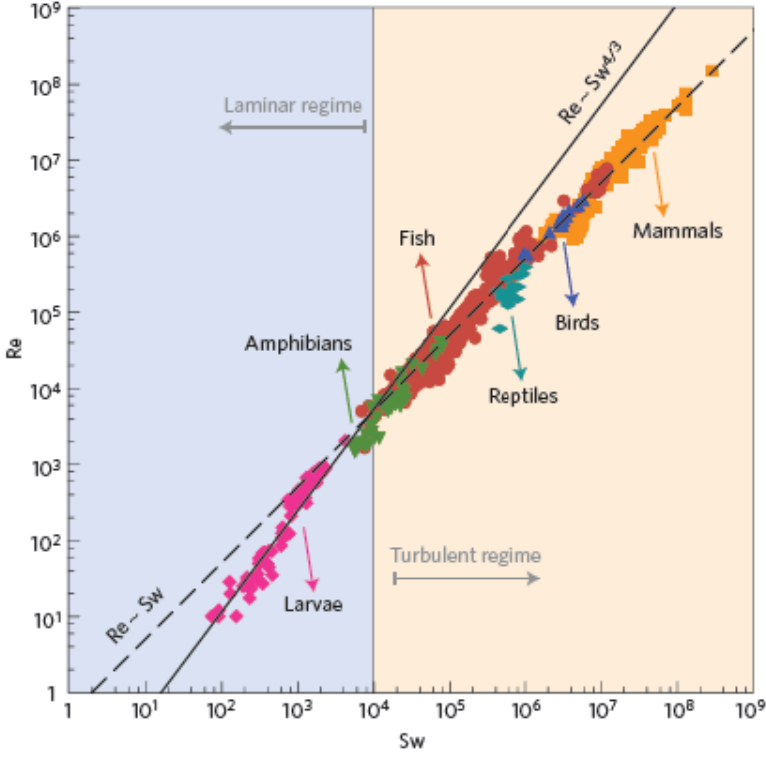
Figure 8. Reynolds against swimming number for several organisms [151].